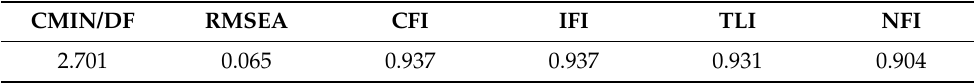
Table 9. Test of the degree of fit of the structural equation